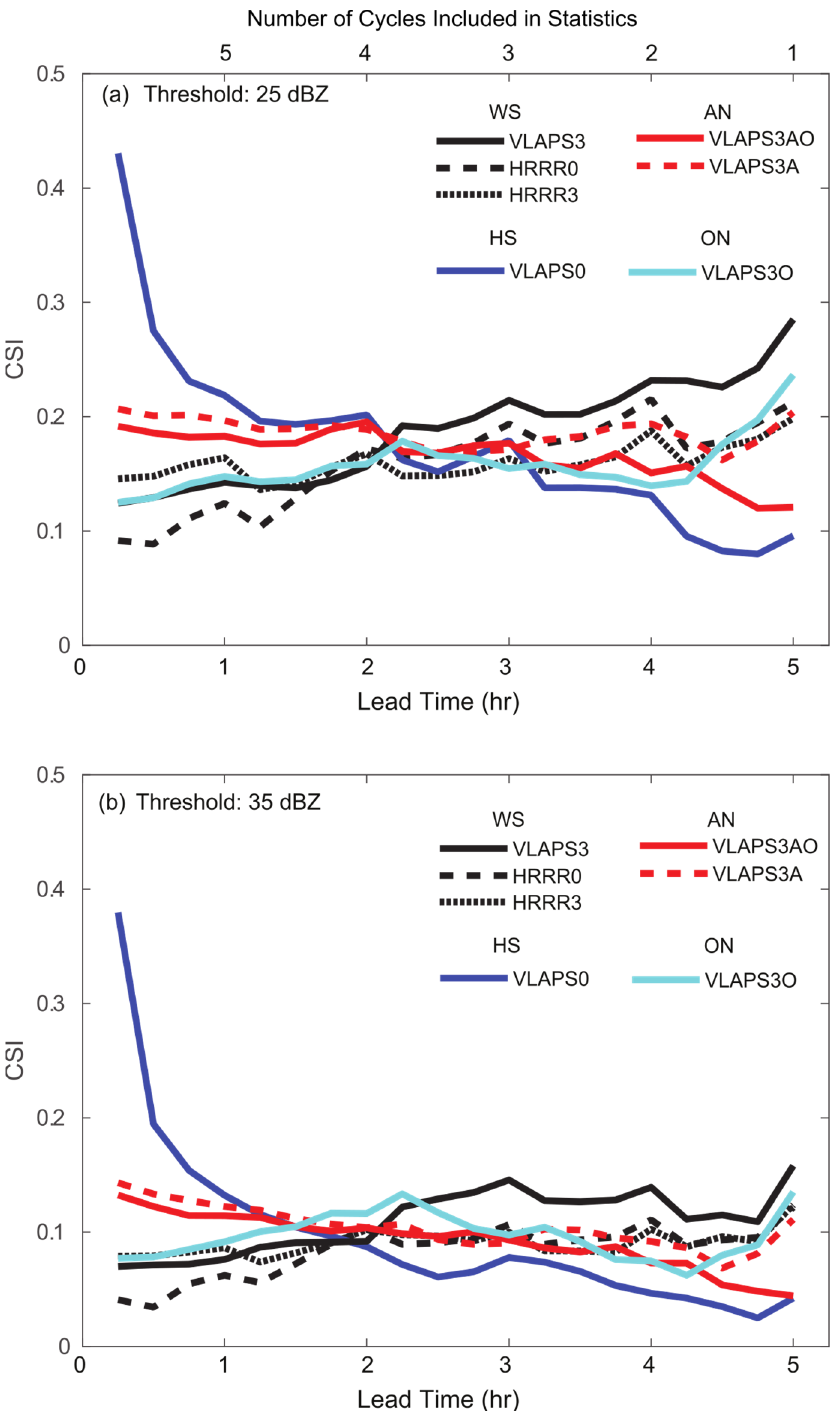
Figure 8 . CSI by lead forecast time (by experiment) and for ( a ) 25 dBZ and ( b ) 35 dBZ reflectivity threshold levels. Line colors indicate whether an experiment is in the warm start (WS), hot start (HS), analysis nudge (AN), or observation nudge (ON) group. The number of cycles included in the statistics at each integer lead time hour is shown along the top of the figure.